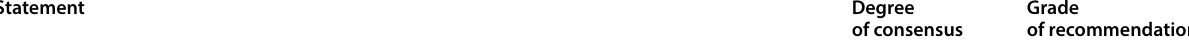
Table 4 Summary of the expert’s recommendations and its degree of consensus and grade of recommendation